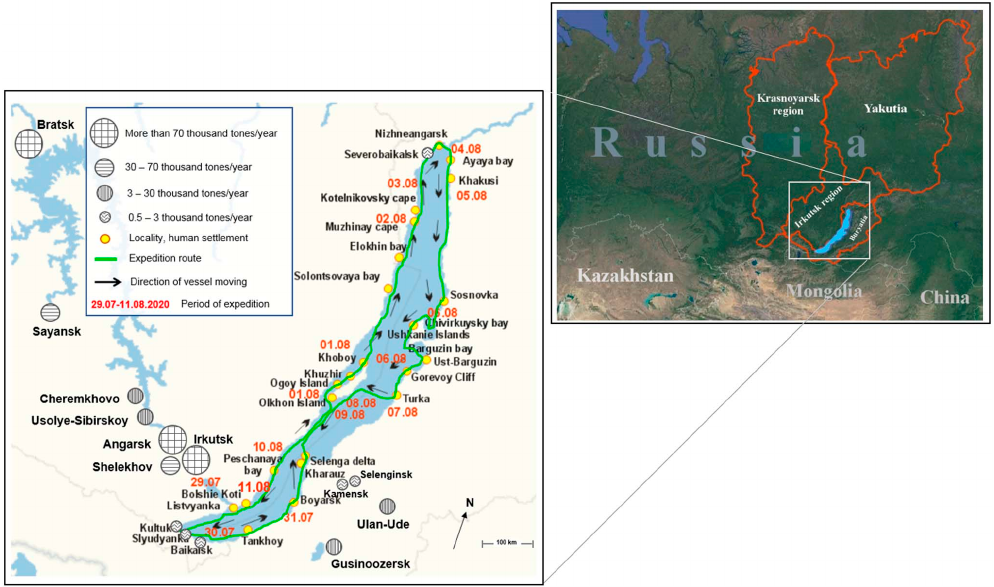
Figure 1. The map of the vessel’s route along the entire perimeter of Lake Baikal and the main stops with dates in the water area of Baikal during the expedition on the research vessel (SRV) “Academician V.A. Koptyug” from 29 July to 11 August 2020.